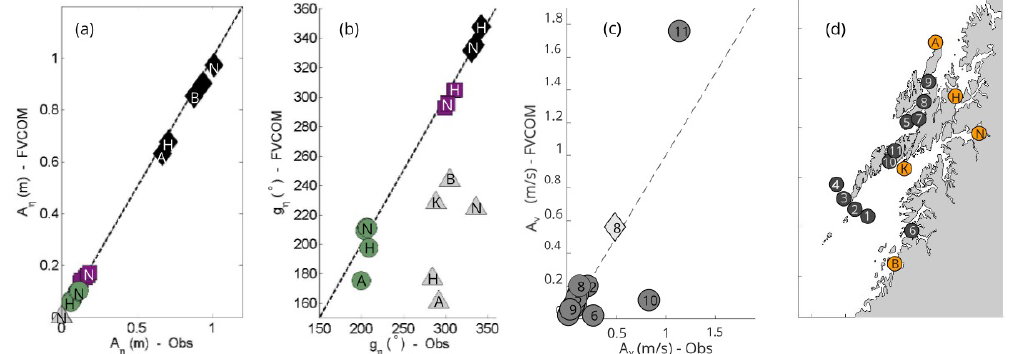
Figure 7. Comparison between modeled and observed tidal properties in Lofoten. Comparisons for the SSH tidal amplitude A η and phase shift g η are displayed in panel (a) and in panel (b) , respectively, for five stations in Lofoten: Andenes (A), Harstad (H), Kabelvåg (K), Narvik (N) and Bodø (B), shown as orange markers in panel (d) . The different tidal constituents considered are M2 (black diamonds), K1 (green circles), N2 (purple squares) and S2 (gray triangles). The observations of SSH are collected from the Norwegian Mapping Authority, Hydrographic Service (2021). Panel (c) shows the comparison between tidal current amplitude in the model and from observations collected from Table 3 of Moe et al. (2002). In total, we compare 11 stations in the Lofoten–Vesterålen region, shown as dark gray markers in the right panel (d) . We compare the M2 tidal current amplitude from all stations (dark gray circles), and in addition the K1 tidal current amplitude from station 8 (light gray diamond) in Sortlandssundet, since this latter station is in a region where the diurnal tidal current (K1) is known to dominate.